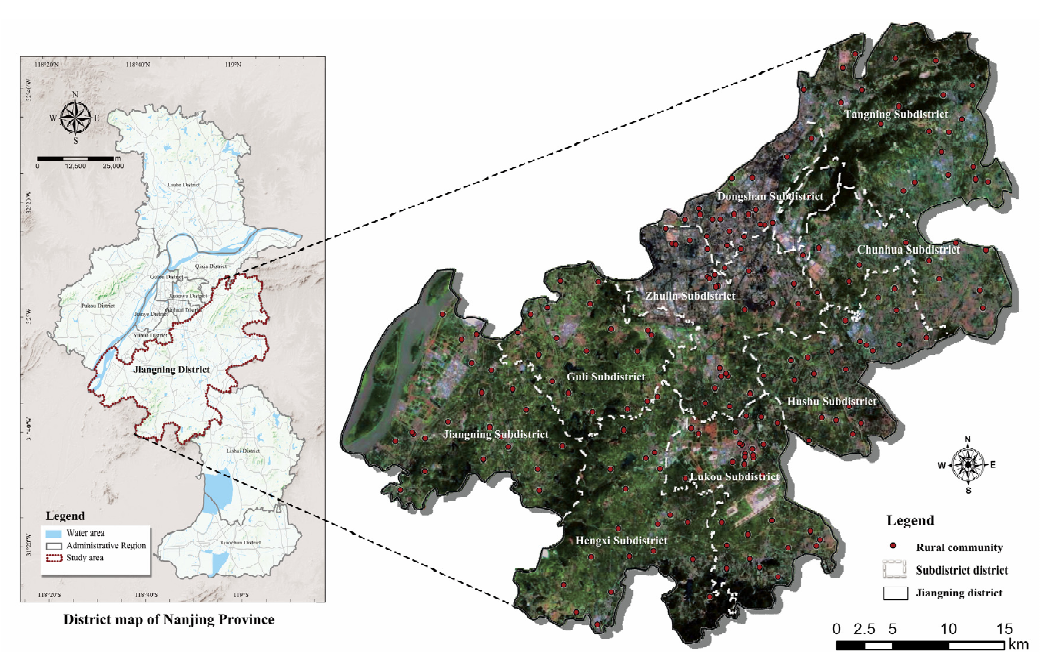
Figure 1. Geographic location and function zoning of the study area.